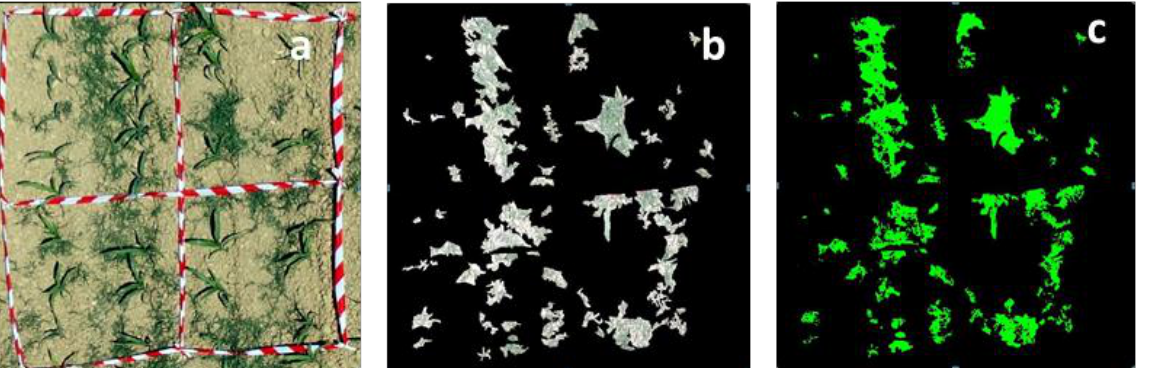
Figure 3. The Erdas method: ( a ) orthorectified RGB image of a control plot, ( b ) the binary image of the control plot where the maize was manually masked, ( c ) the result of the classification of the masked image using the weed signature set.